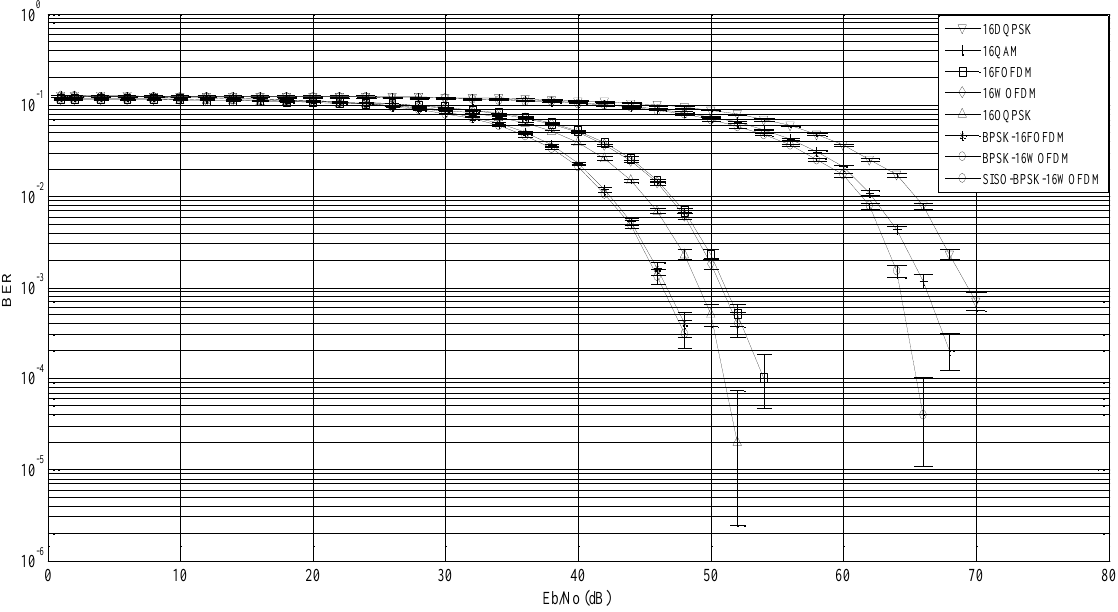
Figure 7. BER performance over transmission distance = 20